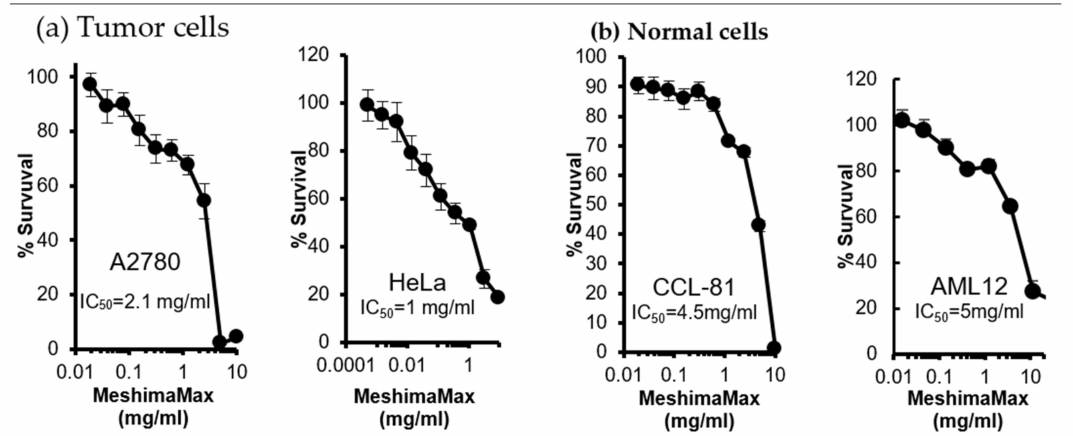
Figure 5. In vitro cytotoxicity of MeshimaMax to di ff erent cells. ( a ) Tumor cells: human ovarian cancer A2780 cells and human cervical cancer HeLa cells. ( b ) Normal cells: monkey kidney epithelial cells CCL-81 and mouse hepatocytes AML12.